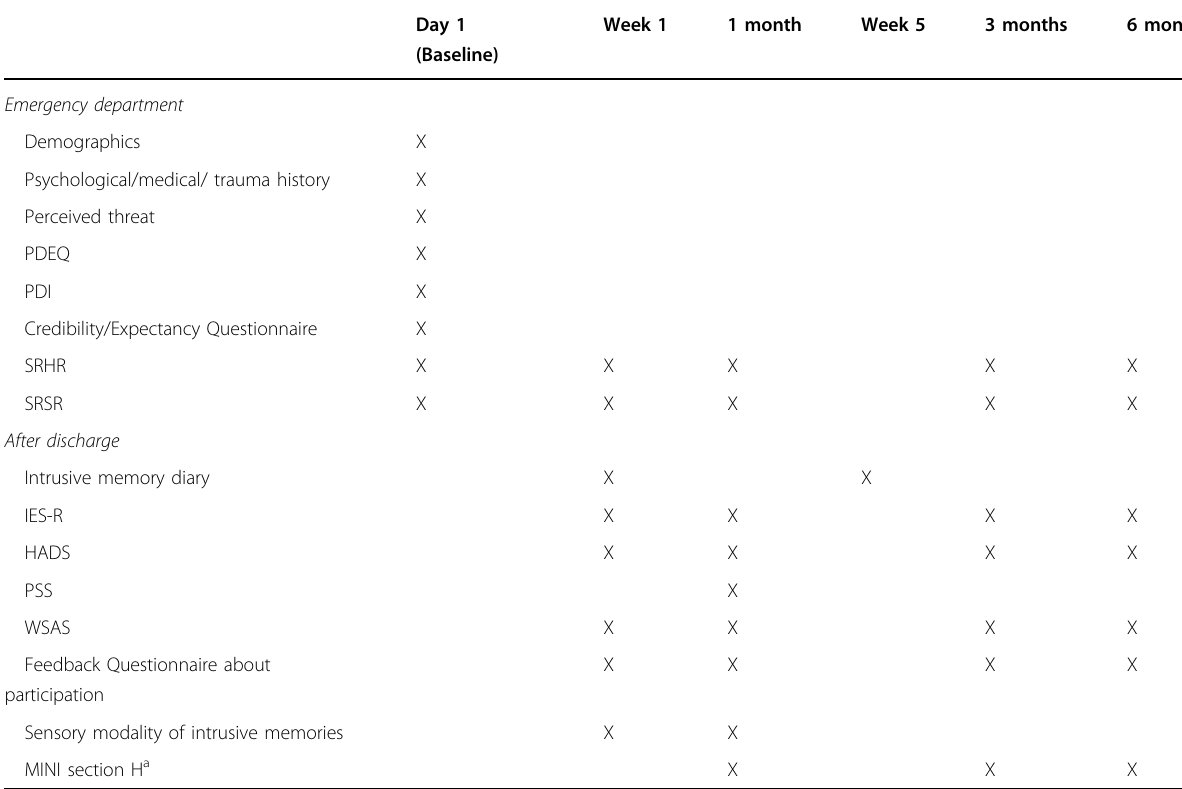
Table 1 Questionnaires at each